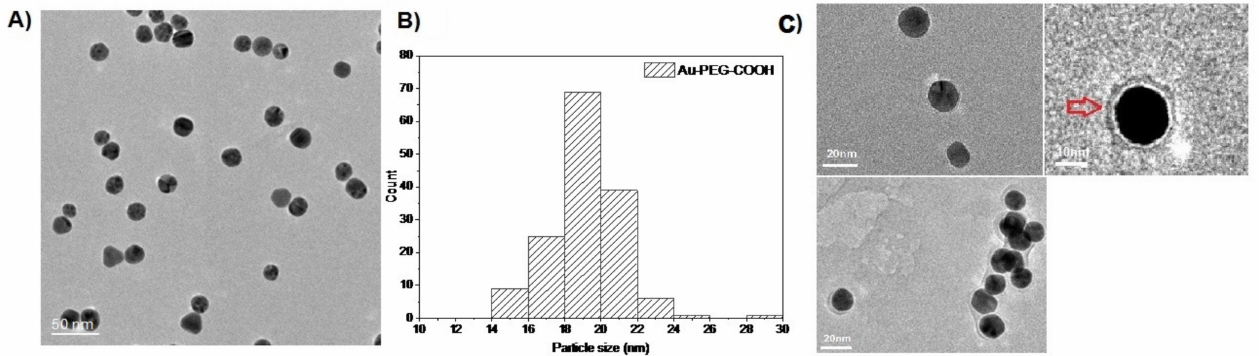
Figure 4. TEM images of ( A ) Au-PEG-COOH nanoparticles. ( B ) Histogram for the size distribution of Au-PEG-COOH. ( C ) Au-PEG-CD133 particles. There is an organic halo around the gold core which may be due to PEG or